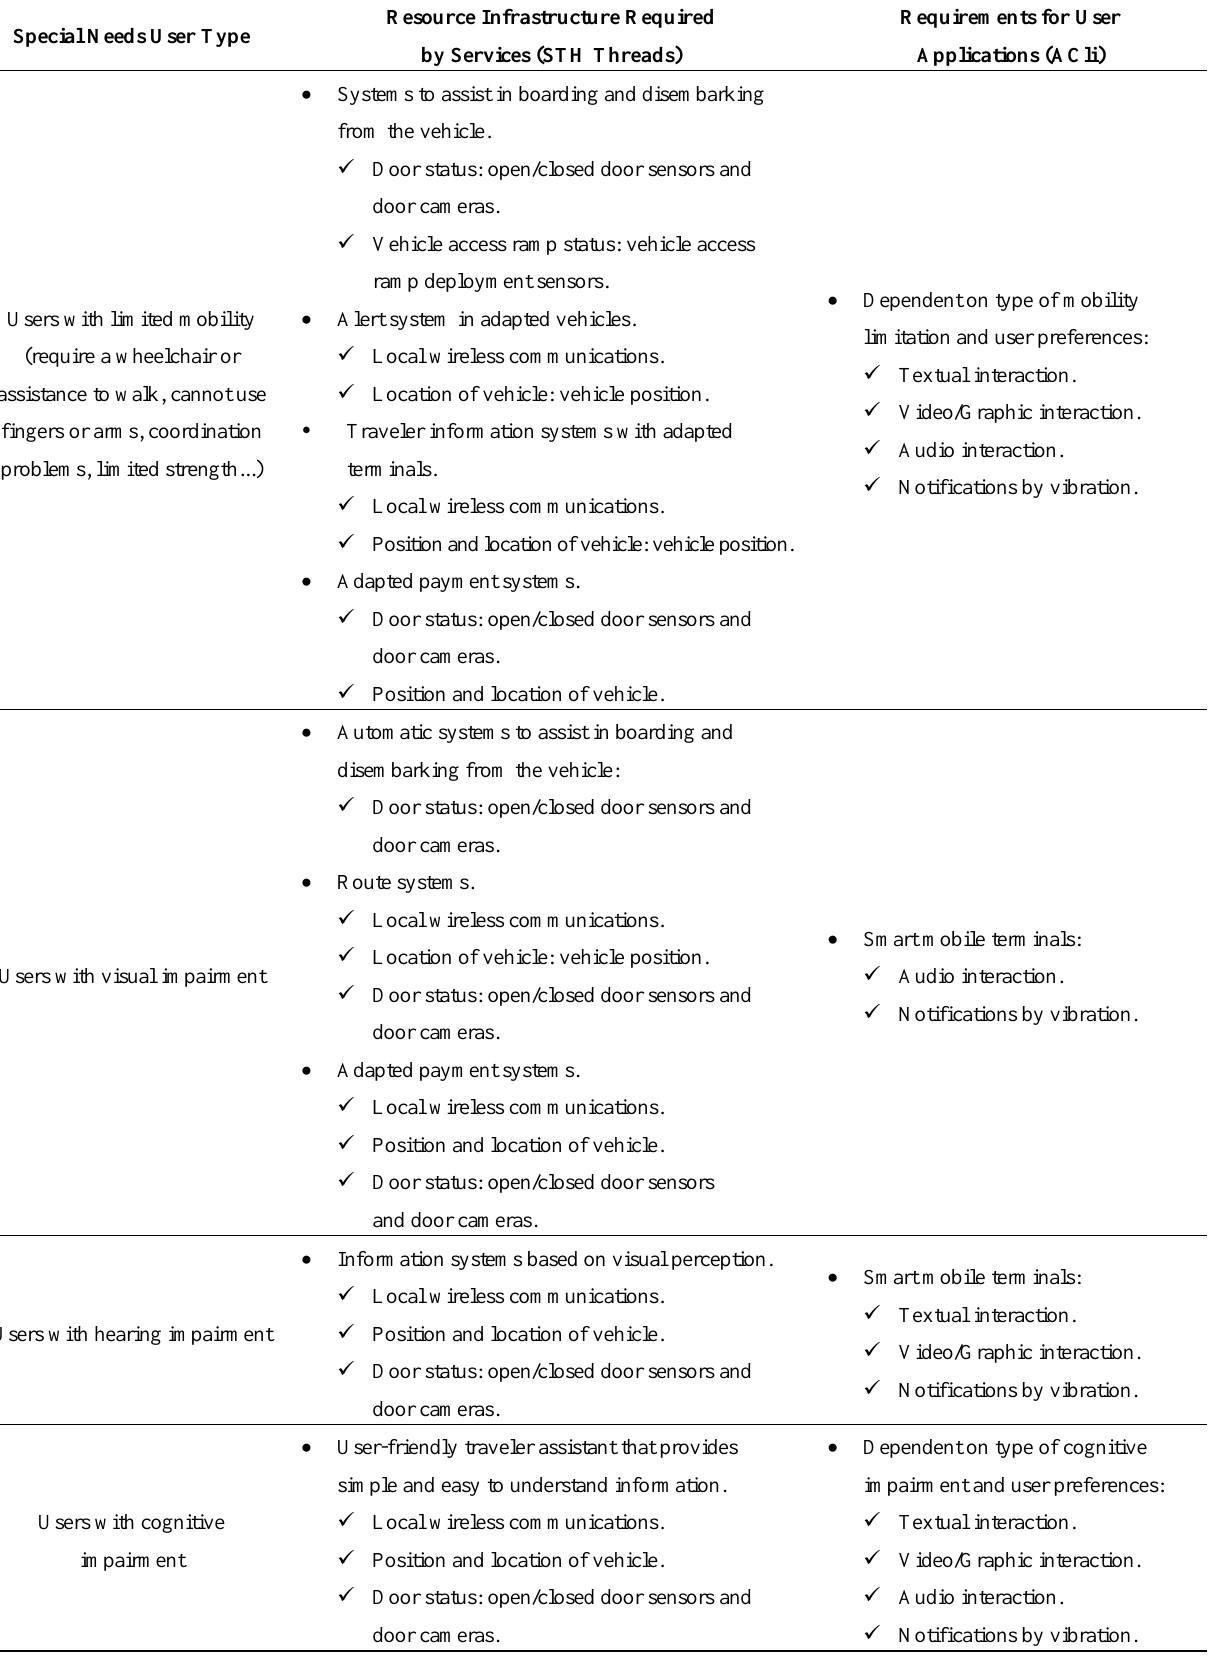
Table 3. Resources and requirements for services (STH threads) and user applications (ACli) depending on the special needs of the